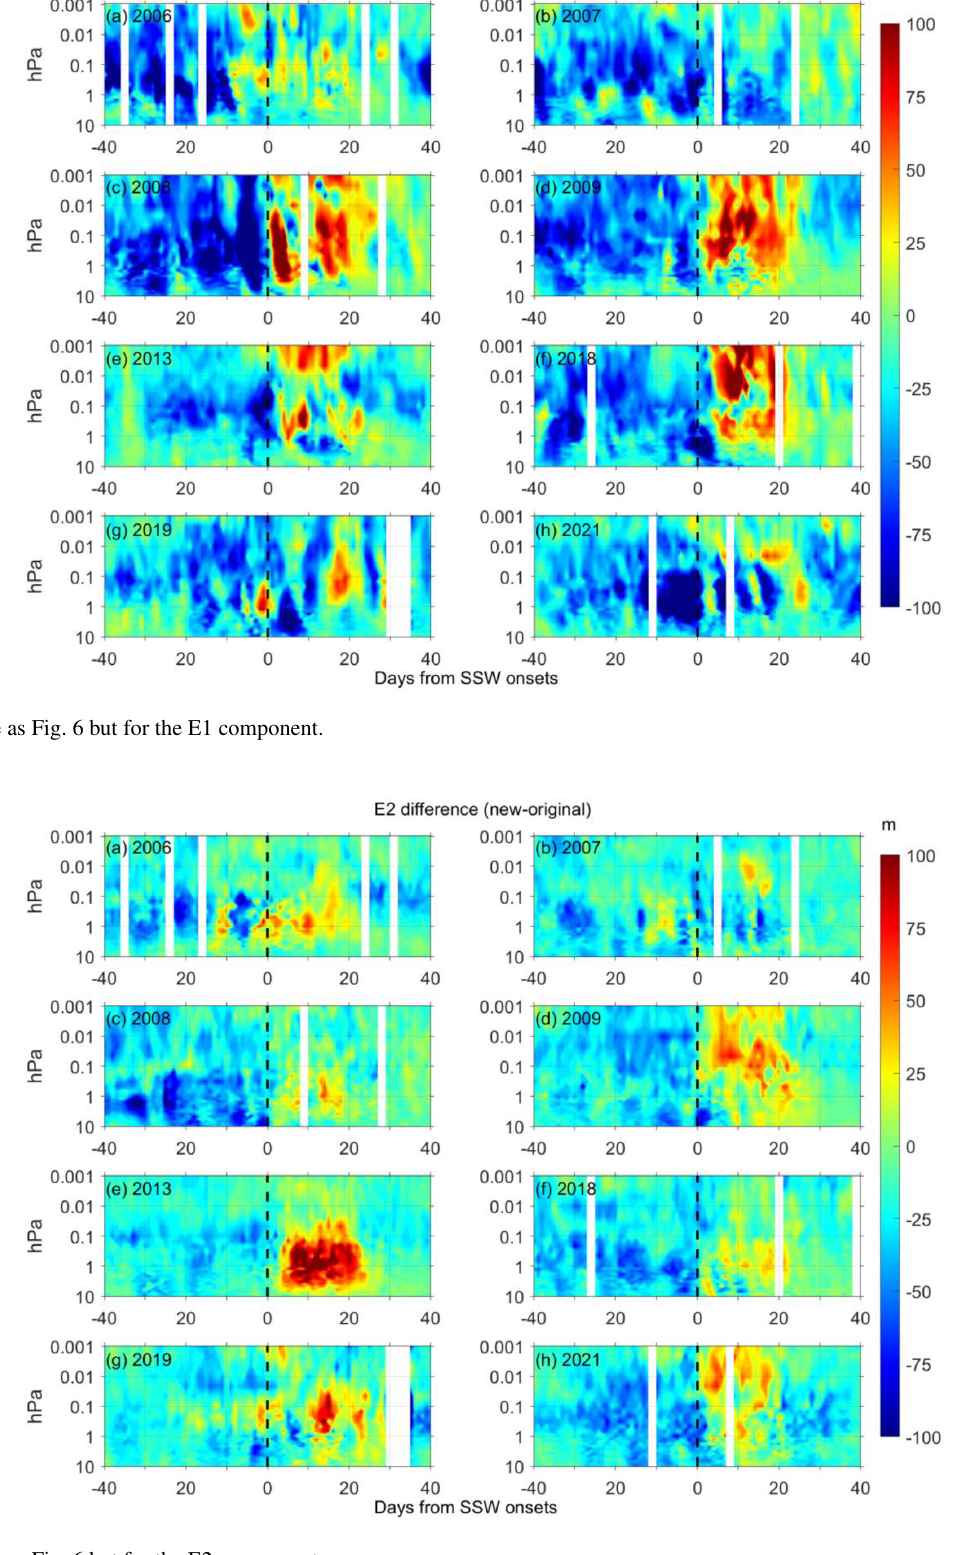
Figure 9. Same as Fig. 6 but for the E2 component.